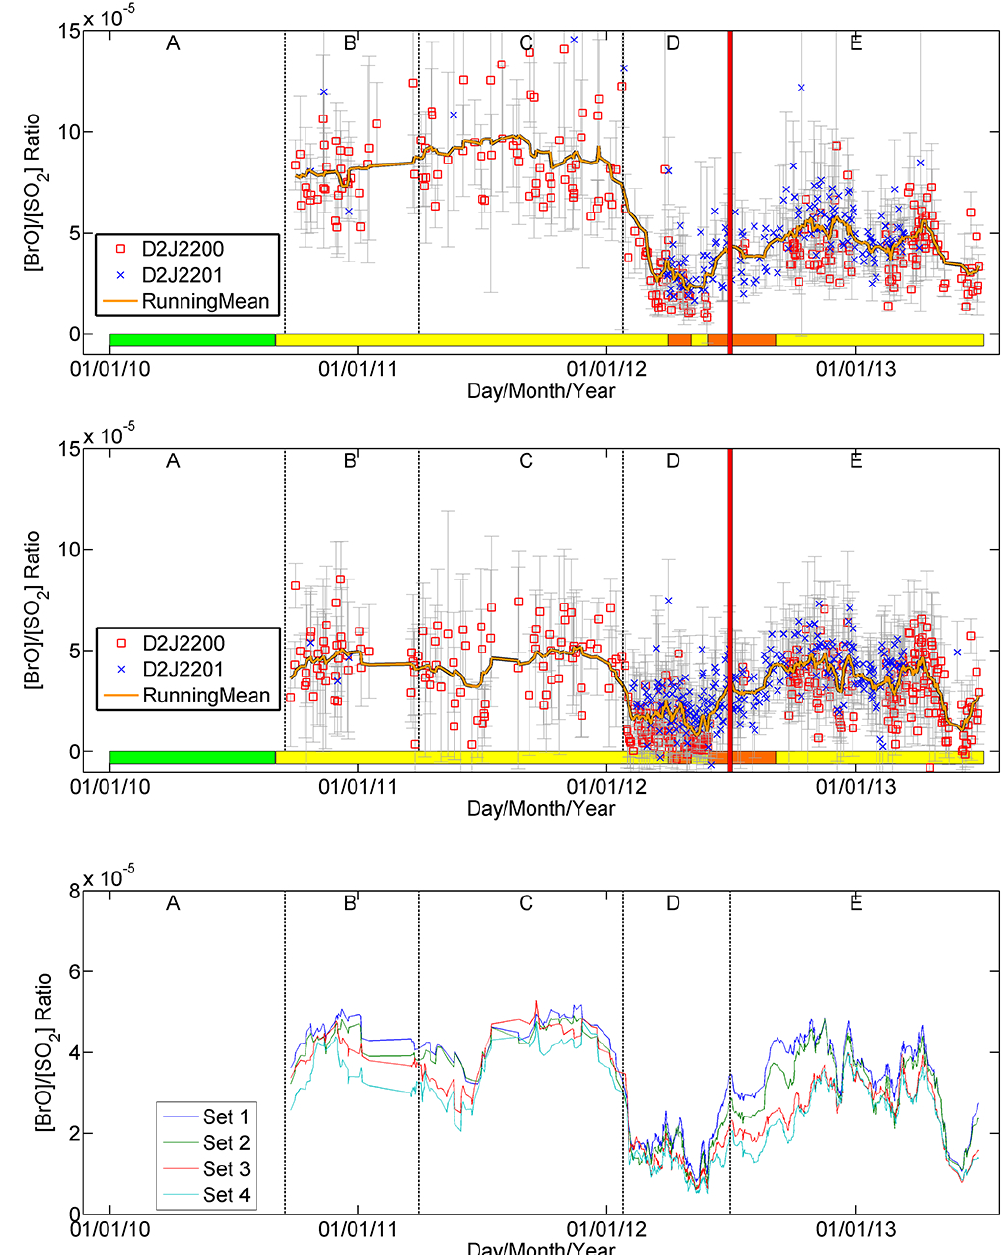
Figure 10. Daily averages of the BrO / SO 2 molar ratios from Nevado del Ruiz from November 2009 to June 2013. The ratio drops down to values below 5 × 10 − 5 , and increases again after the eruption on 30 June 2012 (red vertical bar). Also shown at the bottom of the image is the volcanic activity risk level defined by the Colombian Geological Survey (coloured horizontal bars). The black-orange line shows a running mean around seven data points (from both instruments). Top: the criterion for a valid measurement is a BrO column density above four times the BrO DOAS retrieval error. Center: for this figure an SO 2 threshold of 7 × 10 17 moleculescm − 2 was chosen as the criterion for valid data points. Bottom: Running mean of the BrO / SO 2 time series retrieved in different wavelength ranges, with an SO 2 threshold of of 7 × 10 17 moleculescm − 2 as the criterion for valid data